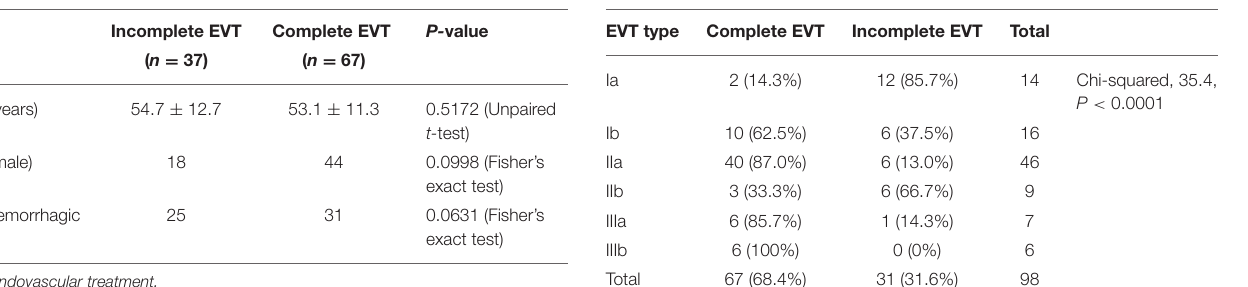
TABLE 6 | Baseline data in patients with incomplete and complete EVTs. TABLE 7 | Statistical analyses of EVT completion.